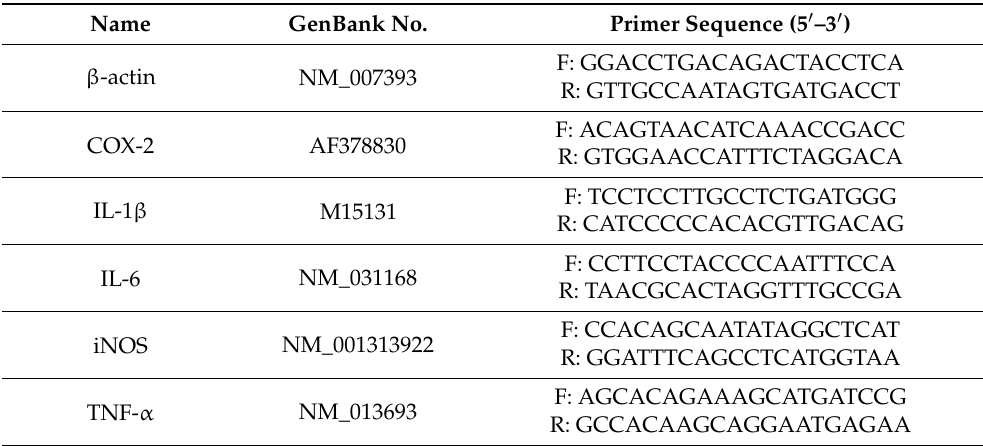
Table 2. Primer sequences used for